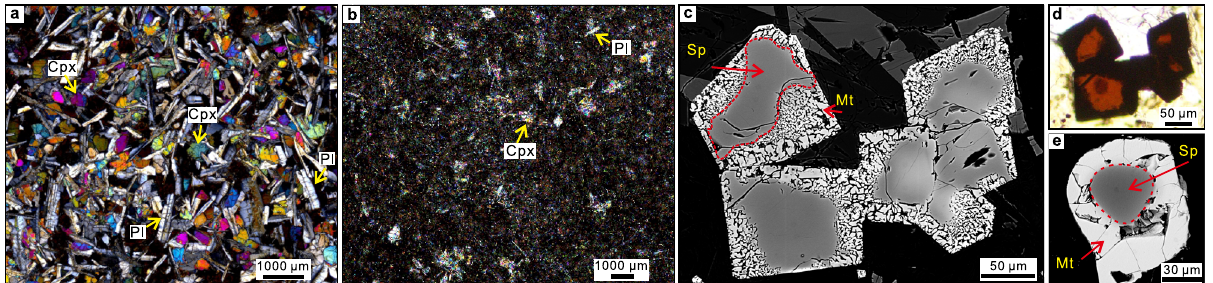
Fig. 2 General and detailed photomicrographs of Unit 1 ASB basalts. a Medium-grained basalt from subunit 1c (78R3 21 – 25), including clinopyroxene (Cpx) and plagioclase (Pl) crystals (crossed polars). b Fine-grained basalt (84R1 84 – 87) from subunit 1e, with small crystals of clinopyroxene and plagioclase (crossed polars). c Back-scatter electron images of spinel; darker colour within the red dash line is aluminous spinel (Sp); brighter colour outside the red dash line is symplectitic magnetite (Mt). d Transmitted light image of the same spinel shown in c, red colour is the Al-rich cores, and opaque boundaries are magnetite. e Back-scatter image of spinel, Al-rich core surrounded by magnetite-rich rim outside the red dash